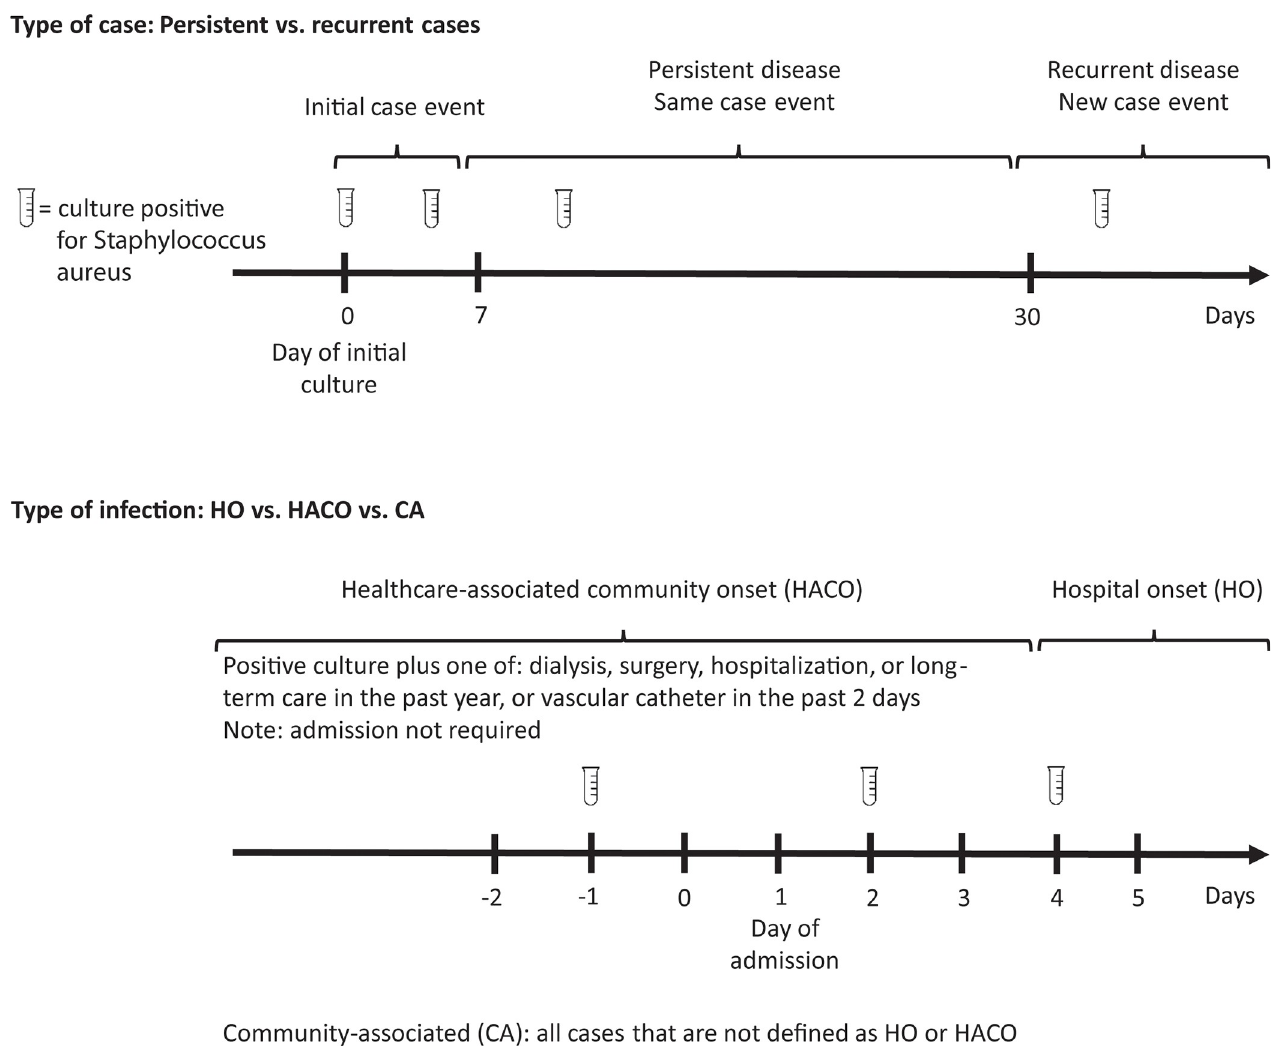
Fig 1. Definitions for the types of invasive Staphylococcus aureus cases and